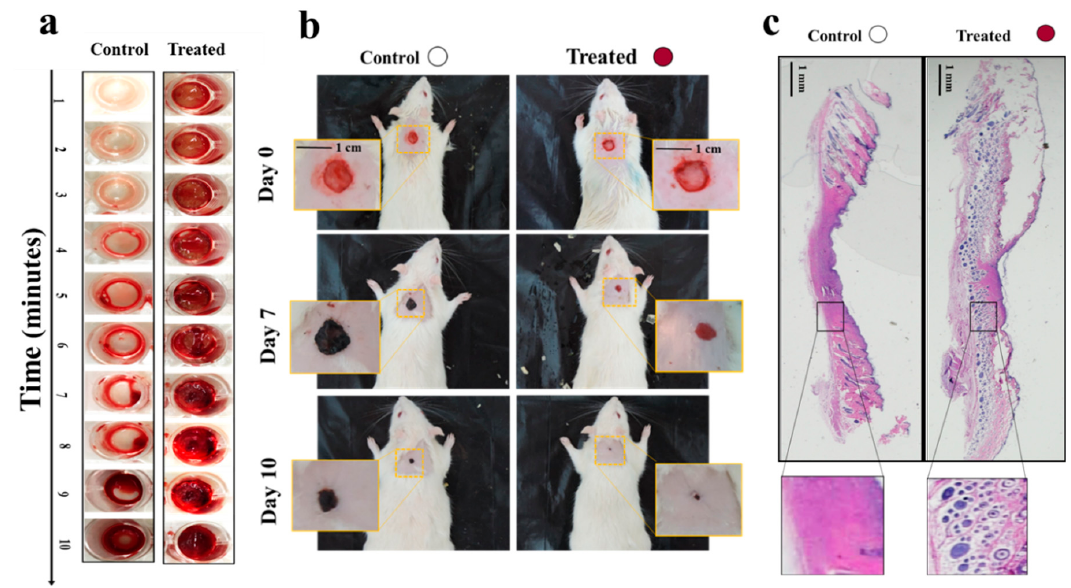
Figure 5. ( a ) Comparison of blood clot formation time in vitro between the control surface (surface without hydrogel) and the treated surface, containing the nanocomposite hydrogel with ZnO/PD and L-glutamic acid; ( b ) differences in wound size between control (untreated) wounds and wounds covered with the nanocomposite hydrogel containing ZnO/PD and L-glutamic acid in vivo; ( c ) histological analyses comparing the appearance of control wounds versus wounds treated with the nanocomposite hydrogel with ZnO/PD and L-glutamic acid in vivo [52] .